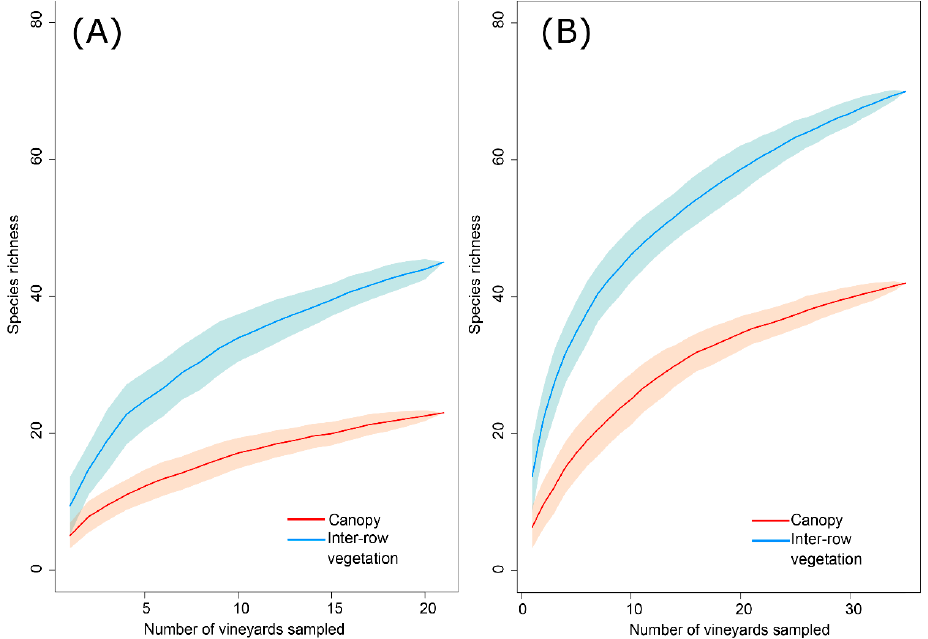
Figure 2. Species accumulation curves based on the amount of vines sampled for ( A ) 2018 and ( B ) 2019 in the canopy and inter-row vegetation. The envelopes correspond to the 95% confidence interval. The majority of the Cicadomorpha species, including vectors and potential vectors of X. fastidiosa , showed a positive correlation with inter-row vegetation (Figure 3).